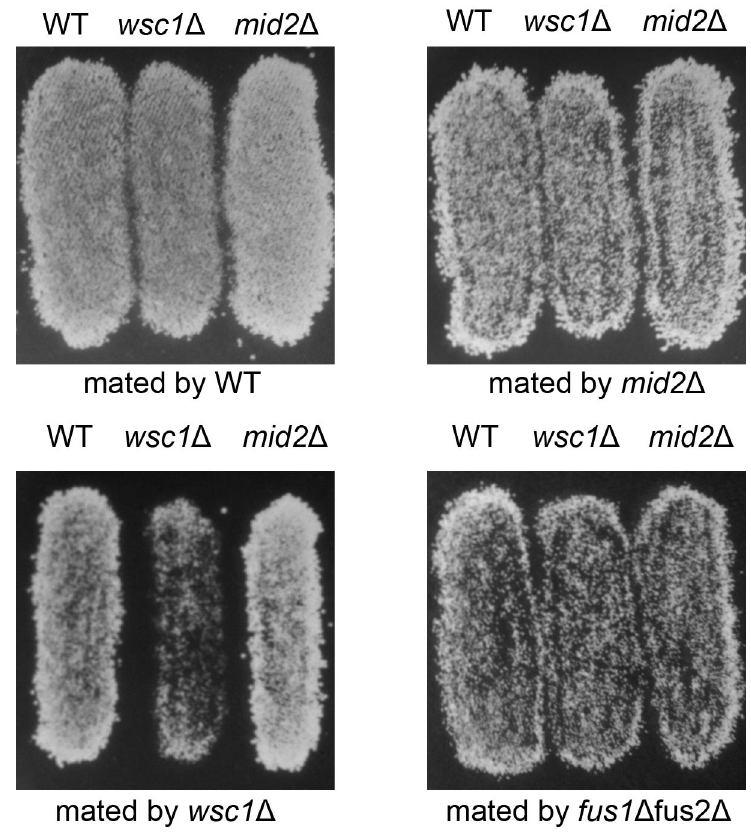
Figure 2. Bilateral loss of WSC1 causes a defect in diploid formation. MAT a patches of WT (MY8092), wsc1 Δ (MY14305), and mid2 Δ (MY14673) were mated to lawns of MAT α , WT (MY8093), wsc1 Δ (MY14306), mid2 Δ (MY14674) and fus1 Δ fus2 Δ (JY429). Cells were mated for 3 h at 30 °C and replica plated onto diploid selective media. In each case the images are of patches of cells growing on 8.5 cm petri dishes; the image panels are 4.0 cm in width.